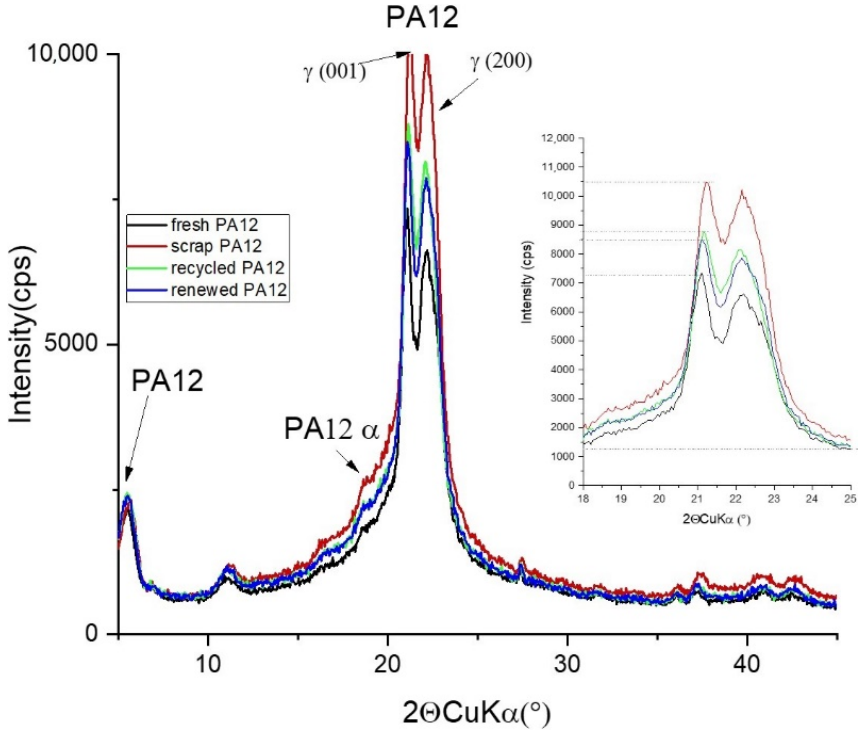
Figure 5. X-ray diffraction (XRD) patterns of all studied samples in range 3–45 ◦ 2 Θ with evaluated α and γ phases of polyamide 12 and detail of studied main γ -PA diffractions in range 18–25 ◦ 2 Θ . Intensity of the peaks is changing during laser sintering process. The relative intensity of fresh PA12 is the lowest of all samples, in contrast to the scrap PA12 sample, where the intensity of both peaks of the γ phase is highest (Table 3). To the intensity progression the findings from the calculation of crystalline thickness size correspond well. For the calculation of mean crystallite size, the Williams–Hall approach using PA 12 (001) and (200) basal diffractions was utilized. Table 3. Structural parameters of studied samples, interlayer space d of two basal diffractions and their full width at half maximum FWHM as well as mean crystallite size were calculated according to the Williams and Hall approach Lc W-H. The interlayer space of both observed highest diffractions did not change much with respect to position; however, the width of peak (001) is narrowest for fresh PA12 as well as renewed PA12 compared to scrap PA12